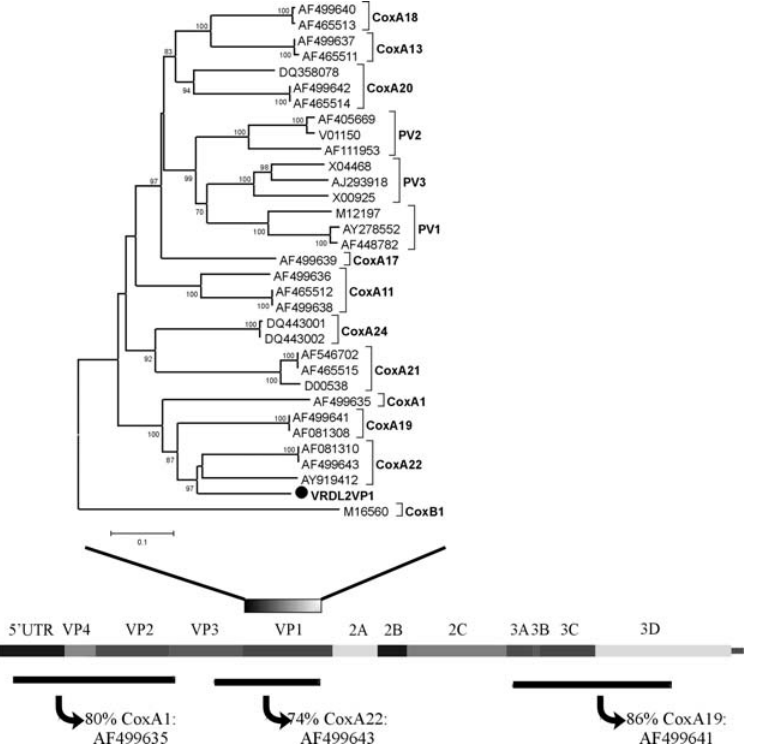
Figure 1. Divergent CoxA22 genotype. Percent nucleotide identity of three VRDL2 fragments (black lines) to closest Blastn enterovirus genome. VP1 amino acid (shaded box) sequence used to create neighbor-joining phlyogenetic tree of HEV-C with bootstrap values from 1000 replicates.